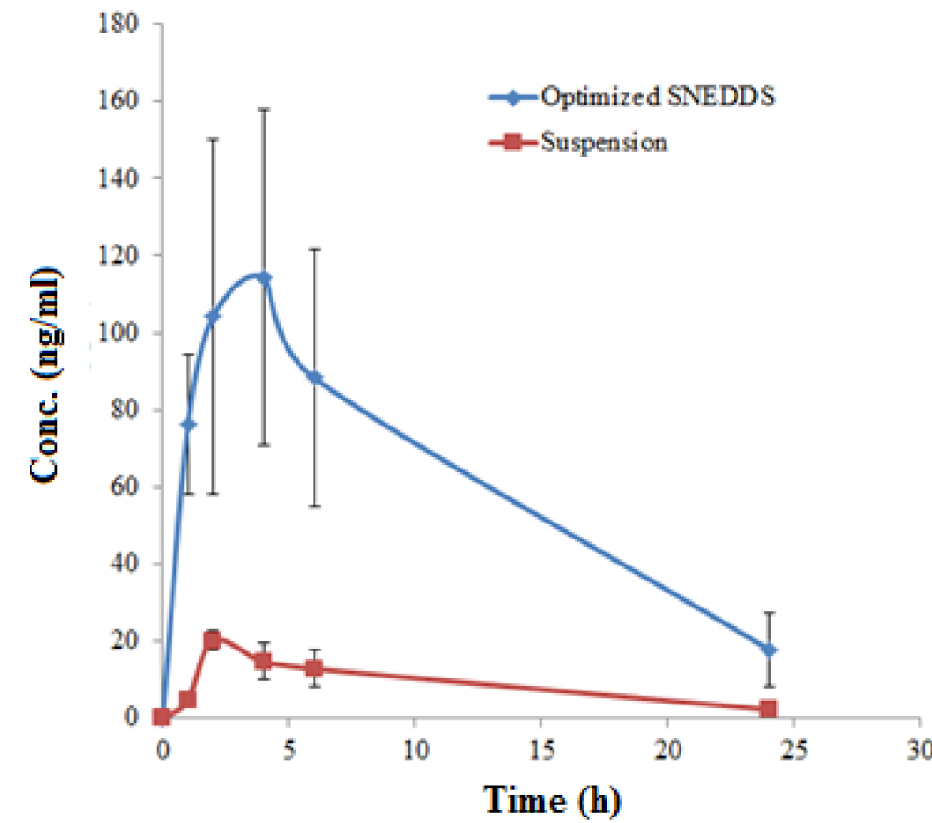
Figure 4. Plasma concentration–time plots of APR after oral administration of optimized SNEDDS and APR suspension in rats (Mean ± SD; n = 6; dose 3 mg / kg). Table 6. Pharmacokinetic parameters of APR after an oral administration of optimized SNEDDS and APR suspension (3 mg/kg) in